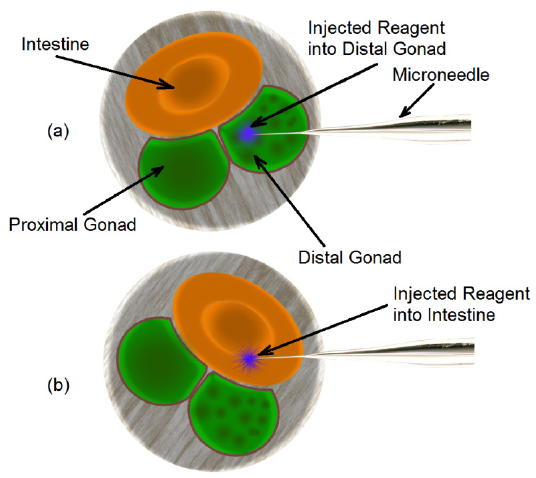
Figure 16. The cross-section of the young adults C. elegans and its alignment relative to the microneedle inside the microinjector. ( a ) The microneedle is properly aligned with the distal gonad ( b ) the microneedle is aligned with the intestine instead of distal gonad and the reagent is delivered into the intestine.